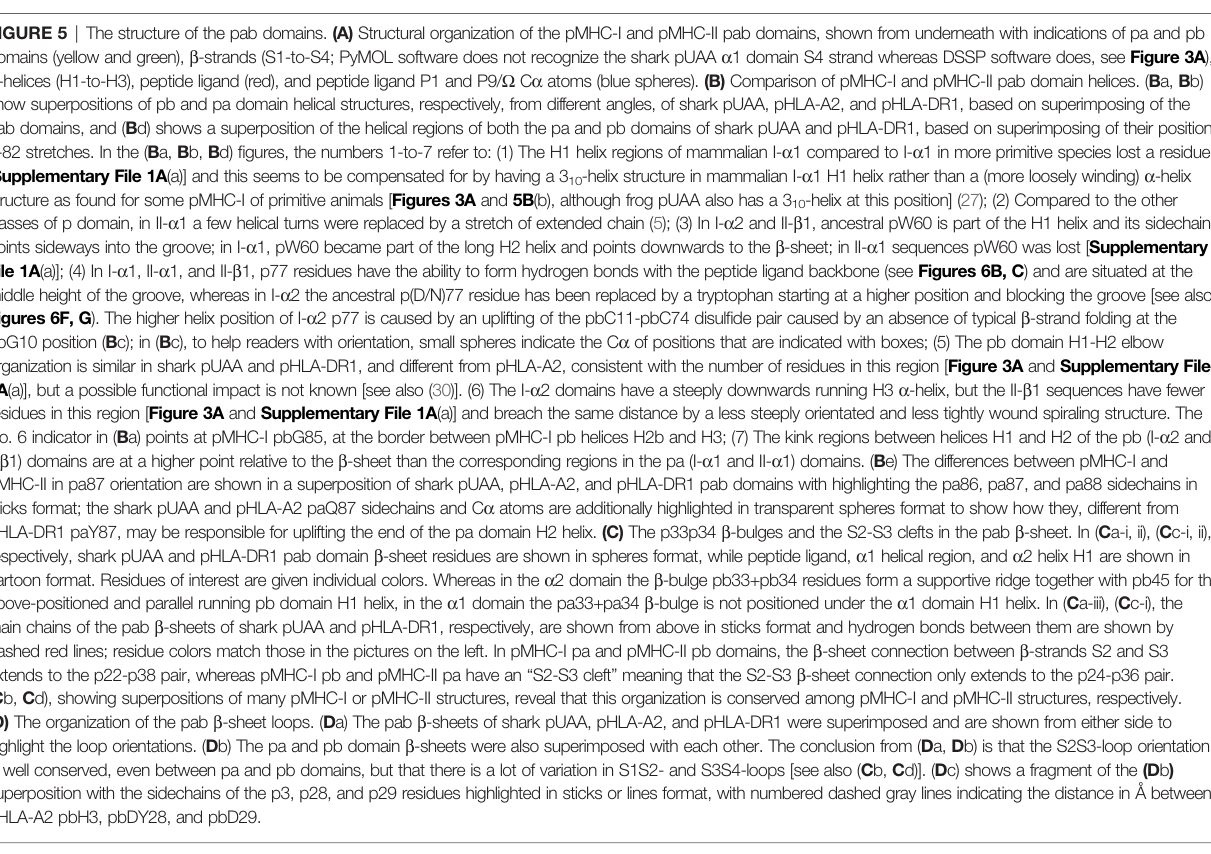
FIGURE 5 | The structure of the pab domains. (A) Structural organization of the pMHC-I and pMHC-II pab domains, shown from underneath with indications of pa and pb domains (yellow and green), b -strands (S1-to-S4; PyMOL software does not recognize the shark pUAA a 1 domain S4 strand whereas DSSP software does, see Figure 3A ), a -helices (H1-to-H3), peptide ligand (red), and peptide ligand P1 and P9/ W C a atoms (blue spheres). (B) Comparison of pMHC-I and pMHC-II pab domain helices. ( B a, B b) show superpositions of pb and pa domain helical structures, respectively, from different angles, of shark pUAA, pHLA-A2, and pHLA-DR1, based on superimposing of the pab domains, and ( B d) shows a superposition of the helical regions of both the pa and pb domains of shark pUAA and pHLA-DR1, based on superimposing of their position 1-82 stretches. In the ( B a, B b, B d) fi gures, the numbers 1-to-7 refer to: (1) The H1 helix regions of mammalian I- a 1 compared to I- a 1 in more primitive species lost a residue [ Supplementary File 1A (a)] and this seems to be compensated for by having a 3 10 -helix structure in mammalian I- a 1 H1 helix rather than a (more loosely winding) a -helix structure as found for some pMHC-I of primitive animals [ Figures 3A and 5B (b), although frog pUAA also has a 3 10 -helix at this position] (27); (2) Compared to the other classes of p domain, in II- a 1 a few helical turns were replaced by a stretch of extended chain (5); (3) In I- a 2 and II- b 1, ancestral pW60 is part of the H1 helix and its sidechain points sideways into the groove; in I- a 1, pW60 became part of the long H2 helix and points downwards to the b -sheet; in II- a 1 sequences pW60 was lost [ Supplementary File 1A (a)]; (4) In I- a 1, II- a 1, and II- b 1, p77 residues have the ability to form hydrogen bonds with the peptide ligand backbone (see Figures 6B, C ) and are situated at the middle height of the groove, whereas in I- a 2 the ancestral p(D/N)77 residue has been replaced by a tryptophan starting at a higher position and blocking the groove [see also Figures 6F, G ). The higher helix position of I- a 2 p77 is caused by an uplifting of the pbC11-pbC74 disul fi de pair caused by an absence of typical b -strand folding at the pbG10 position ( B c); in ( B c), to help readers with orientation, small spheres indicate the C a of positions that are indicated with boxes; (5) The pb domain H1-H2 elbow organization is similar in shark pUAA and pHLA-DR1, and different from pHLA-A2, consistent with the number of residues in this region [ Figure 3A and Supplementary File 1A (a)], but a possible functional impact is not known [see also (30)]. (6) The I- a 2 domains have a steeply downwards running H3 a -helix, but the II- b 1 sequences have fewer residues in this region [ Figure 3A and Supplementary File 1A (a)] and breach the same distance by a less steeply orientated and less tightly wound spiraling structure. The No. 6 indicator in ( B a) points at pMHC-I pbG85, at the border between pMHC-I pb helices H2b and H3; (7) The kink regions between helices H1 and H2 of the pb (I- a 2 and II- b 1) domains are at a higher point relative to the b -sheet than the corresponding regions in the pa (I- a 1 and II- a 1) domains. ( B e) The differences between pMHC-I and pMHC-II in pa87 orientation are shown in a superposition of shark pUAA, pHLA-A2, and pHLA-DR1 pab domains with highlighting the pa86, pa87, and pa88 sidechains in sticks format; the shark pUAA and pHLA-A2 paQ87 sidechains and C a atoms are additionally highlighted in transparent spheres format to show how they, different from pHLA-DR1 paY87, may be responsible for uplifting the end of the pa domain H2 helix. (C) The p33p34 b -bulges and the S2-S3 clefts in the pab b -sheet. In ( C a-i, ii), ( C c-i, ii), respectively, shark pUAA and pHLA-DR1 pab domain b -sheet residues are shown in spheres format, while peptide ligand, a 1 helical region, and a 2 helix H1 are shown in cartoon format. Residues of interest are given individual colors. Whereas in the a 2 domain the b -bulge pb33+pb34 residues form a supportive ridge together with pb45 for the above-positioned and parallel running pb domain H1 helix, in the a 1 domain the pa33+pa34 b -bulge is not positioned under the a 1 domain H1 helix. In ( C a-iii), ( C c-i), the main chains of the pab b -sheets of shark pUAA and pHLA-DR1, respectively, are shown from above in sticks format and hydrogen bonds between them are shown by dashed red lines; residue colors match those in the pictures on the left. In pMHC-I pa and pMHC-II pb domains, the b -sheet connection between b -strands S2 and S3 extends to the p22-p38 pair, whereas pMHC-I pb and pMHC-II pa have an “ S2-S3 cleft ” meaning that the S2-S3 b -sheet connection only extends to the p24-p36 pair. ( C b, C d), showing superpositions of many pMHC-I or pMHC-II structures, reveal that this organization is conserved among pMHC-I and pMHC-II structures, respectively. (D) The organization of the pab b -sheet loops. ( D a) The pab b -sheets of shark pUAA, pHLA-A2, and pHLA-DR1 were superimposed and are shown from either side to highlight the loop orientations. ( D b) The pa and pb domain b -sheets were also superimposed with each other. The conclusion from ( D a, D b) is that the S2S3-loop orientation is well conserved, even between pa and pb domains, but that there is a lot of variation in S1S2- and S3S4-loops [see also ( C b, C d)]. ( D c) shows a fragment of the (D b ) superposition with the sidechains of the p3, p28, and p29 residues highlighted in sticks or lines format, with numbered dashed gray lines indicating the distance in Å between pHLA-A2 pbH3, pbDY28, and